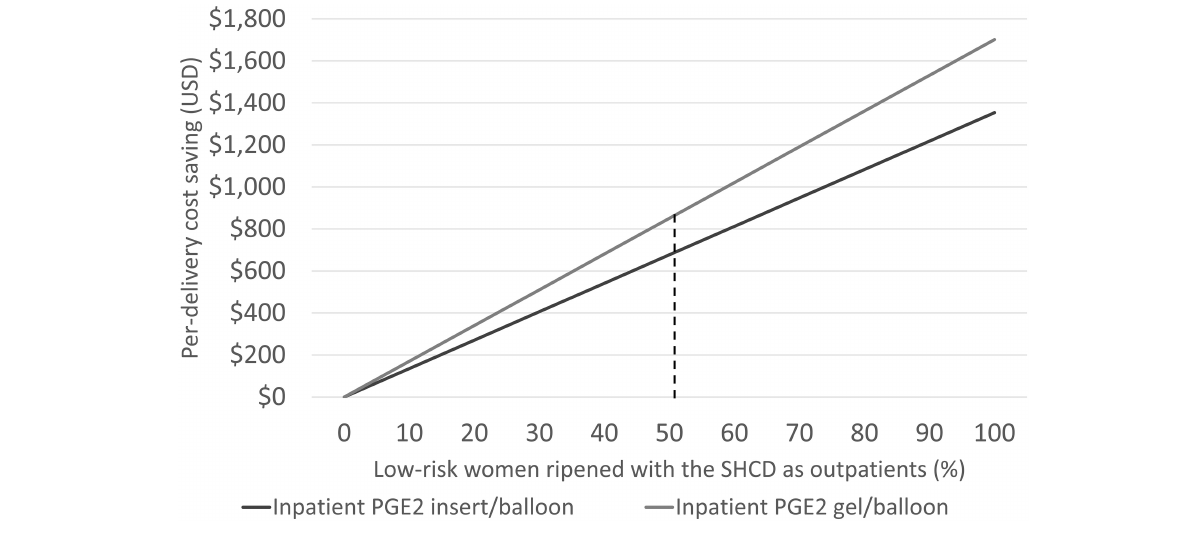
Less Time Spent in the Hospital ( Table 1 ) was added to the in-hospital L&D time and not to the time in outpatient ripening. In practice one may expect more time saved in the L&D unit for women in the outpatient